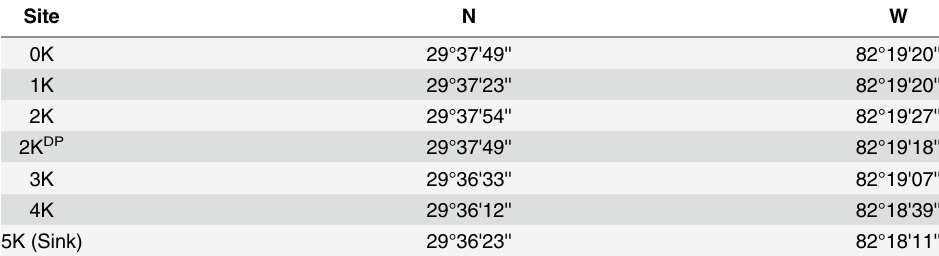
Table 1. Geographic coordinates for each of the sampling points in this